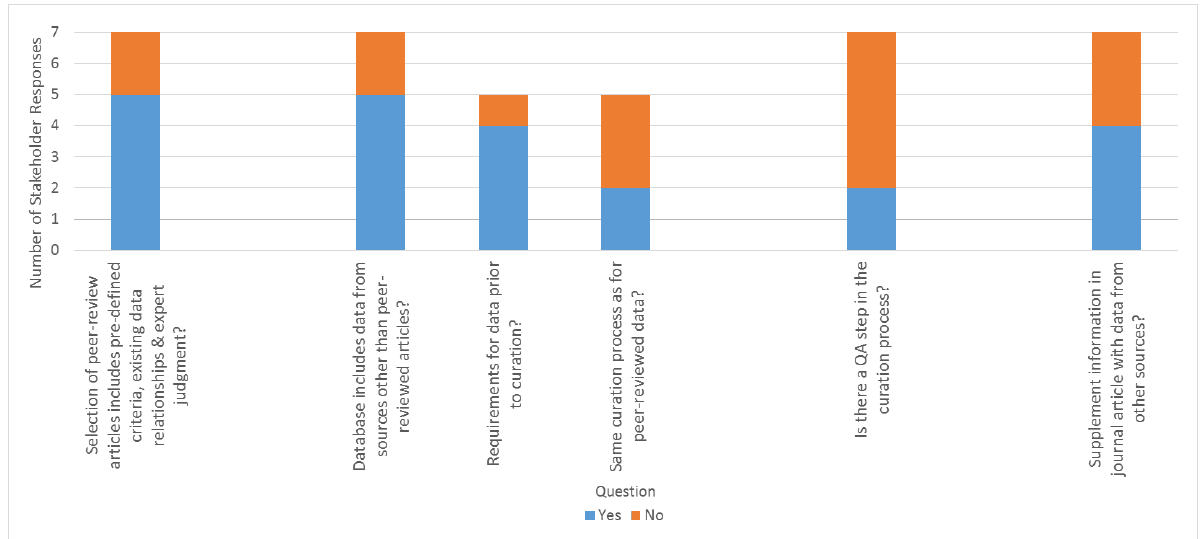
was no process for non-curators to submit data to the